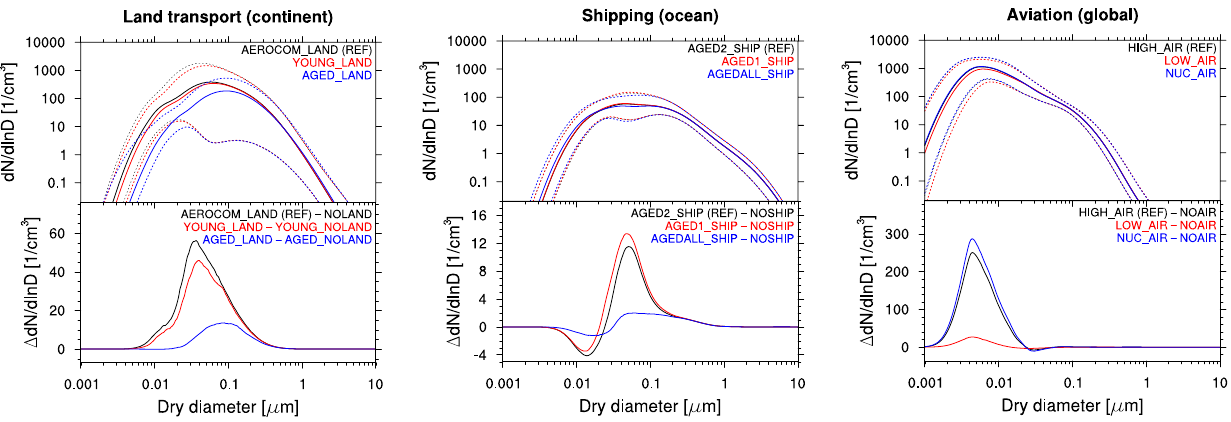
Fig. 9. Aerosol median size distributions for land transport (left), shipping (middle) and aviation (right). In the case of land transport (ship- ping), the size distributions are calculated considering the continental (oceanic) grid boxes only, and the two lowermost model layers. Aviation impacts are calculated on the global domain, in model layers 7 to 9 ( ∼ 8–13km). The top panels show the median distributions (solid lines) as well as the 25 and 75% quartiles (dotted lines). The bottom panels show the differences in the median size distributions between experiments with and without the given transport source. Median and quartiles are calculated by considering 200 logarithmic size bins in the 10 − 3 –10µm range and analyzing number concentrations in each